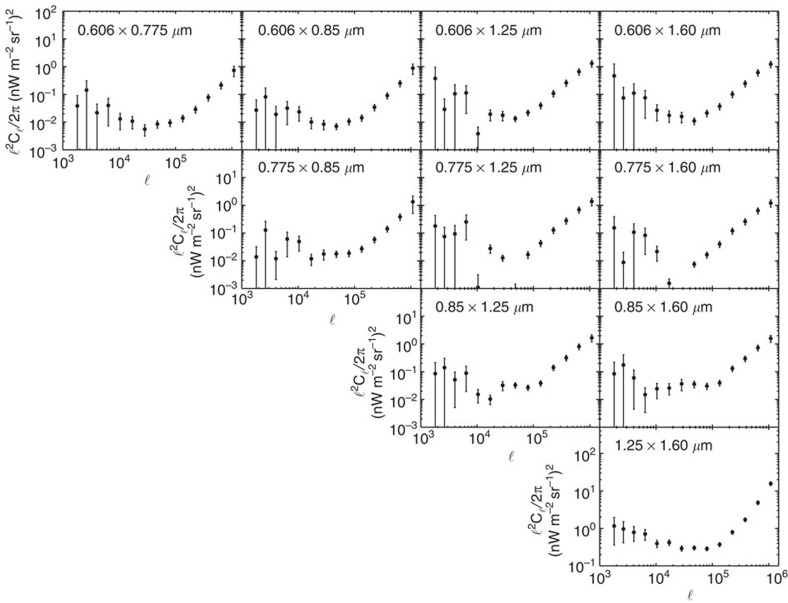
Angular cross- power spectra of optical and near-infrared background.Ten cross-correlations between the HST bands. Excess signal is detected in the cross-correlations. The error bars are 1σ uncertainties which are calculated in a similar way as in Fig. 3, which accounts for all sources of noise and error, including map-making, calibration, detector noise, and cosmic variance. However, the noise power spectra for the cross-correlations are calculated slightly differently. For each filter we have two maps, so for each cross-correlation between bands we have four maps (label them A and B for the first filter, and C and D for the second). This enables us to generate a noise power spectrum by computing (A–B) × (C–D), as opposed to taking the auto-spectrum of (A–B) for the autocorrelations. The first row corresponds to all correlations with the 0.606-μm band, the second for all correlations with the 0.775-μm band not found in the first row, the third row corresponds to all correlations with the 0.850-μm band not found in any of the preceding rows, and the last row corresponds to correlations at 1.25 μm. The columns similarly increase in wavelength as you move across the page.